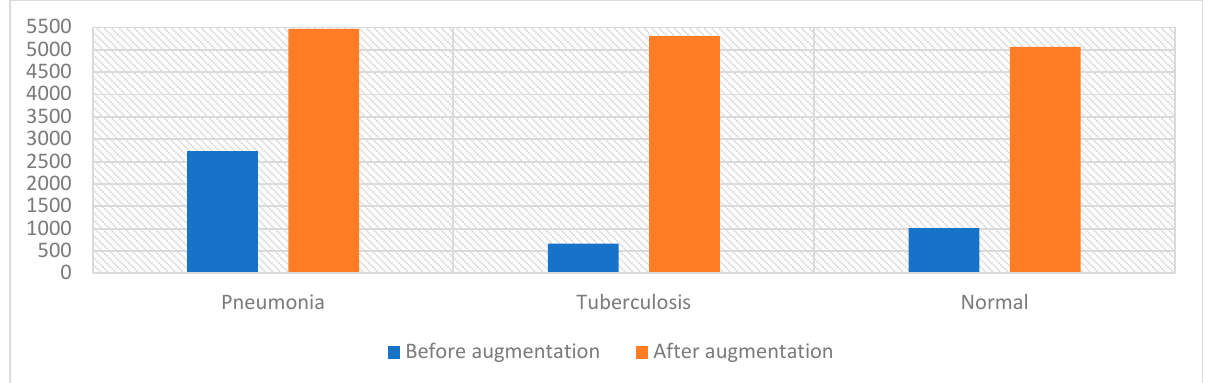
Figure 6. The number of X-rays of pneumonia and tuberculosis in the data set before and after applying the data augmentation technique.